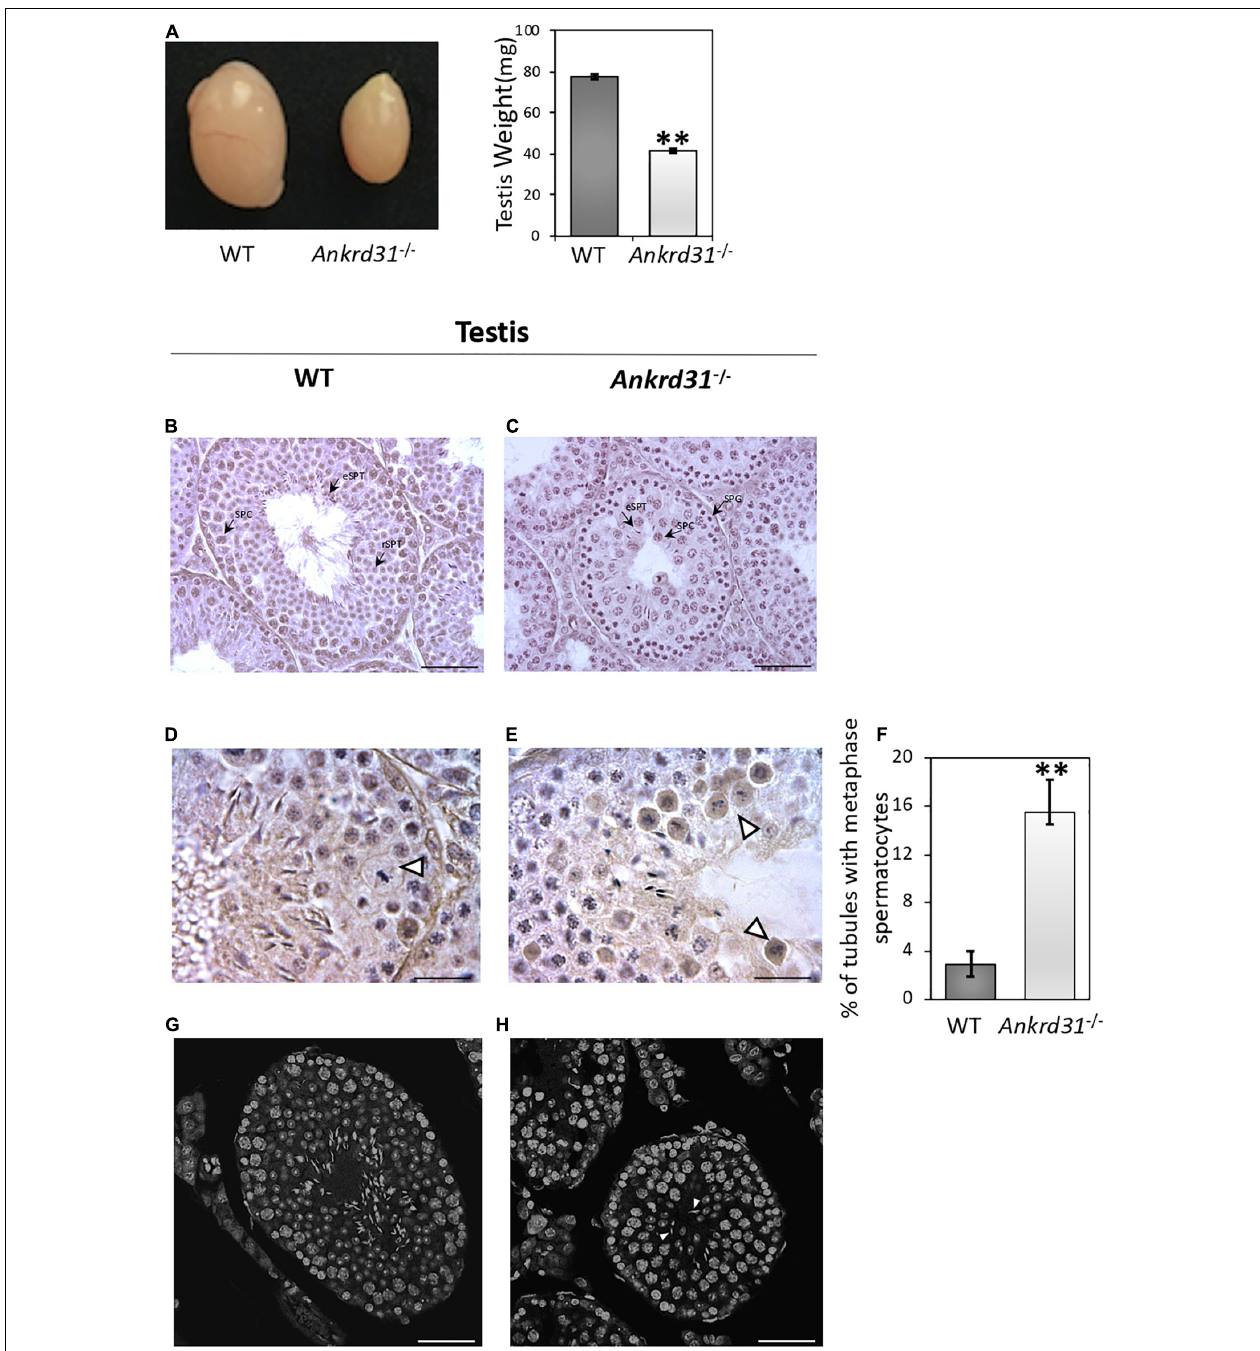
FIGURE 2 | Morphological characterization of Ankrd31 − / − testes. (A) Comparative size analysis between WT and Ankrd31 − / − testes. Testis weight (mg) analysis was carried out on WT and Ankrd31 − / − testes ( n = 20). Data are reported as mean value ± S.E.M. (B,C) Defective spermatogenesis was observed by H&E staining of WT and Ankrd31 − / − Bouin’s fixed seminiferous tubule sections (7 µ m) collected from 8-week-old testes. SPG, spermatogonia; SPC, spermatocytes; rSPT, round spermatids; eSPT, elongated spermatids (black-arrowheads). (D,E) Cells in metaphase are indicated by white arrowheads. (F) Quantification of seminiferous tubules containing spermatocytes in metaphase in WT and Ankrd31 − / − testes ( n = 10 for each genotype). The number of total tubules counted in five different animals for each genotype corresponded to n = 650. Data are expressed as percentage (%) of tubules containing cells in metaphase and reported as mean ± SEM, ** p < 0.01. (G,H) Classification of germ cells in respect to chromatin structure marked with DAPI staining in WT and Ankrd31 − / − testicular sections (7 µ m). The elongated spermatids not correctly oriented toward seminiferous lumen are indicated by white arrowheads. (B–H) Scale bar corresponds to 50 µ m; (D,E) scale bar corresponds to 25 µ m.